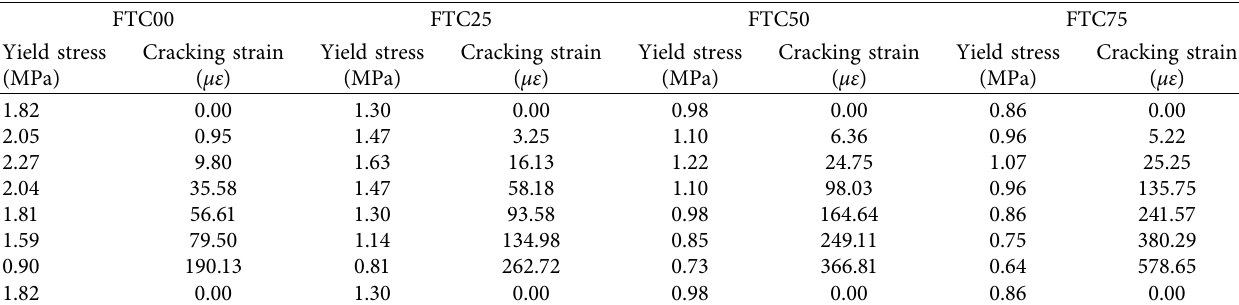
Table 4: Data of yield stress and cracking strain of uniaxial tensile behavior for the CDP model. FTC00 FTC25 FTC50 FTC75 Yield stress Cracking strain